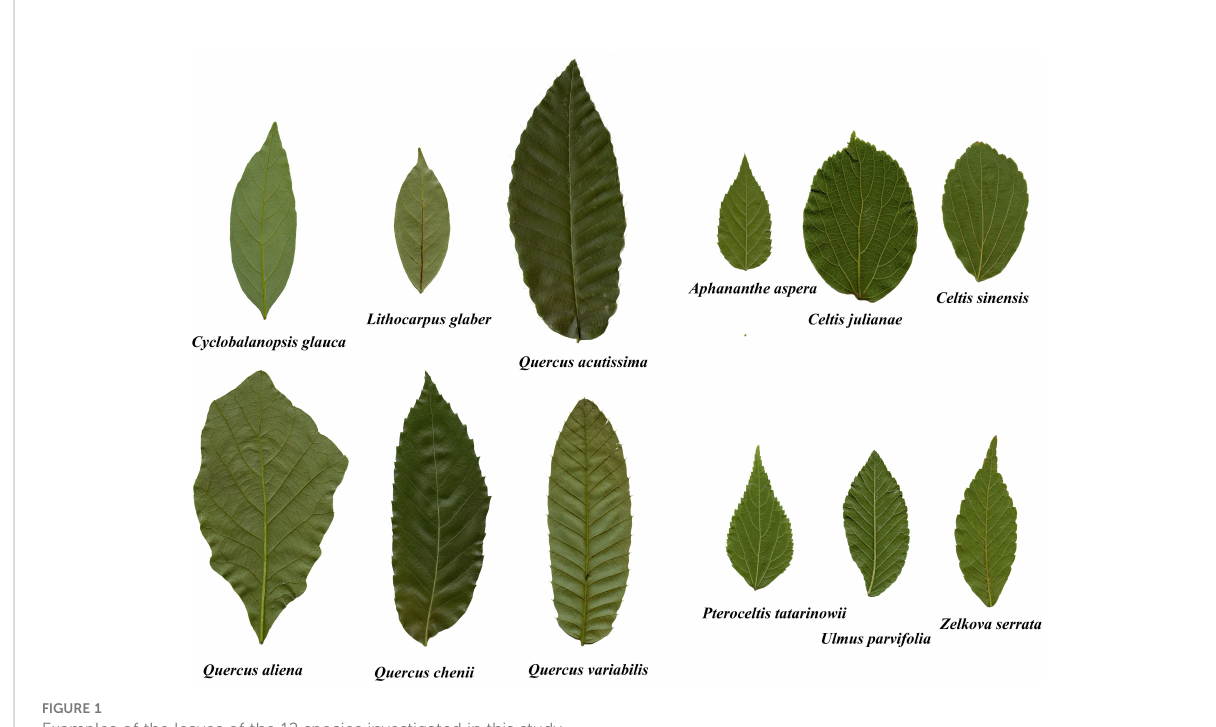
FIGURE 1 Examples of the leaves of the 12 species investigated in this